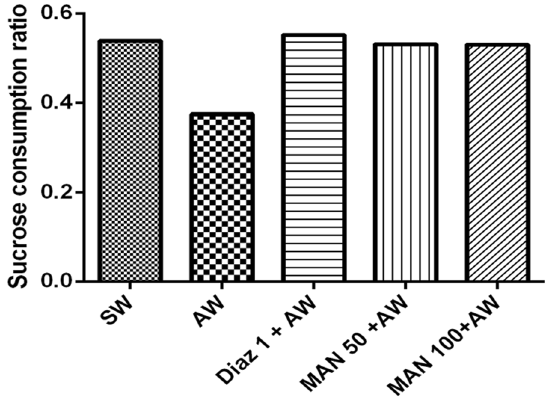
Fig. 5 Effect of MAN (50 and 100 mg/kg p.o.) on alcohol withdrawal-induced sucrose preference in